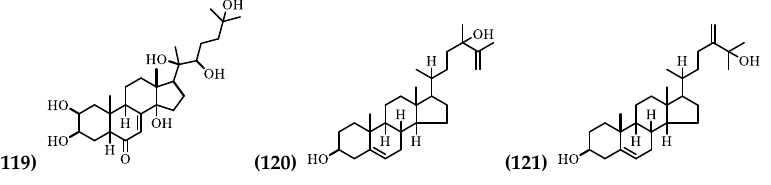
Table 6. Hydrocarbons from Brugmansia suaveolens. Figure 6. Structure of Steroids from Brugmansia suaveolens. Figure 6. Structure of Steroids from Brugmansia suaveolens.